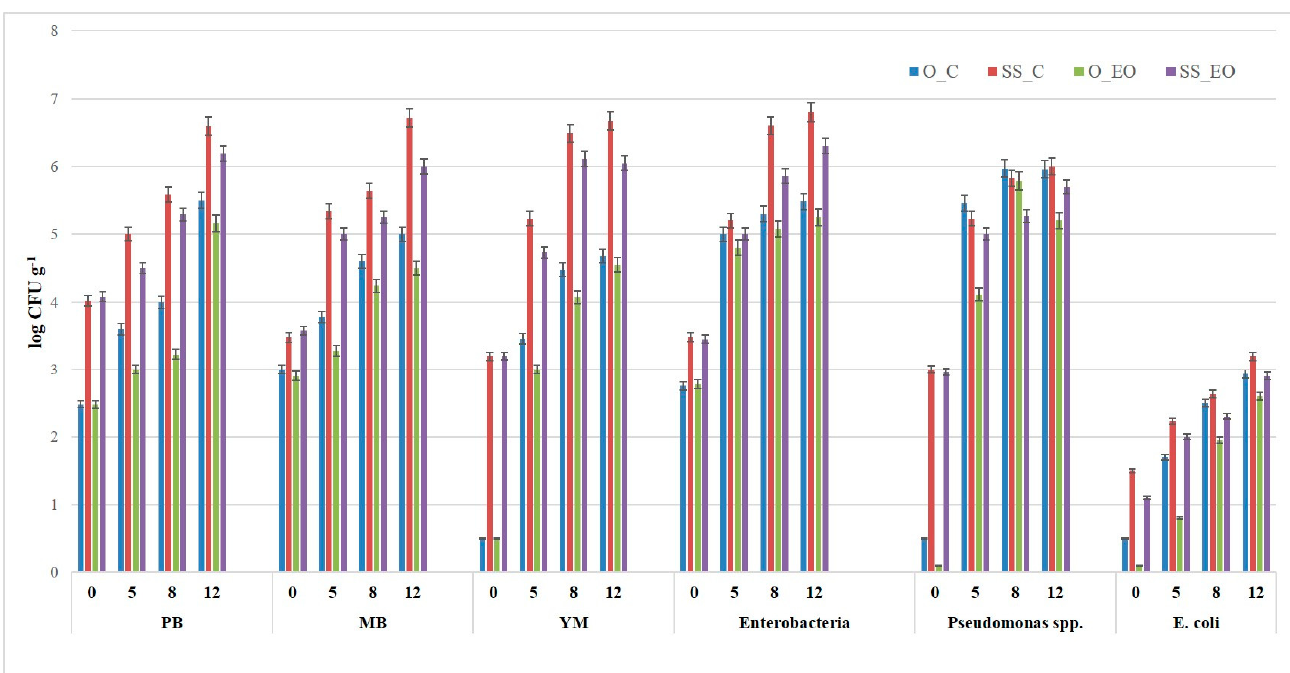
Figure 8. Microbiological parameters of RTC globe artichoke slices as affected by “genotype × post-harvest treatment × storage time” interaction. LSD interaction ( p ≤ 0.05): 0.06 (total mesophilic bacteria, MB); 0.07 (total psychrotrophic bacteria, PB); 0.05 (yeasts and molds, YM); 0.07 (Enterobacteria, TEB); 0.08 ( Pseudomonas spp.); 0.08 ( E. coli ). Data are presented as means ± standard deviation.